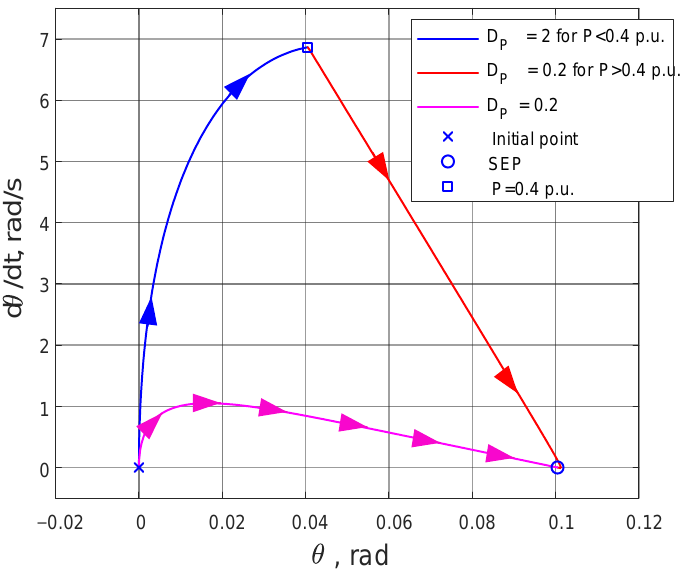
Figure 11. Trajectories for systems with variable droop factor D p restart and systems with constant droop factor D p of 0.2 p.u./Hz.